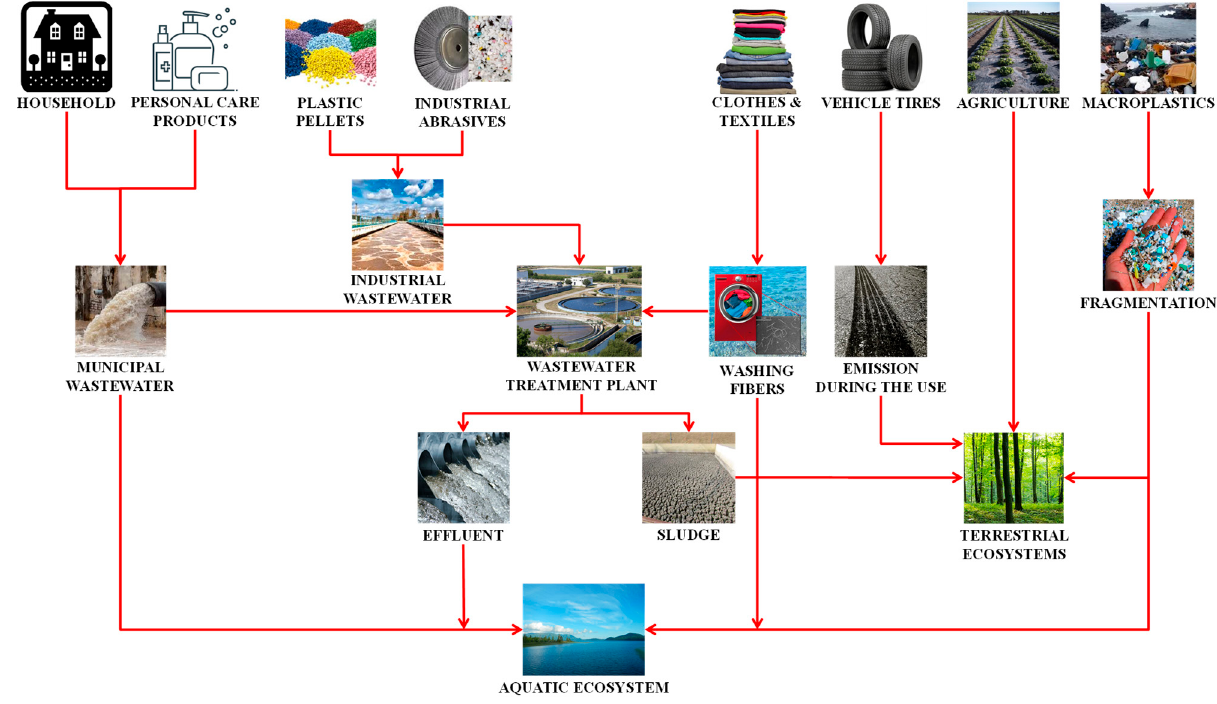
Figure 2. Sources of microplastics in the environment.